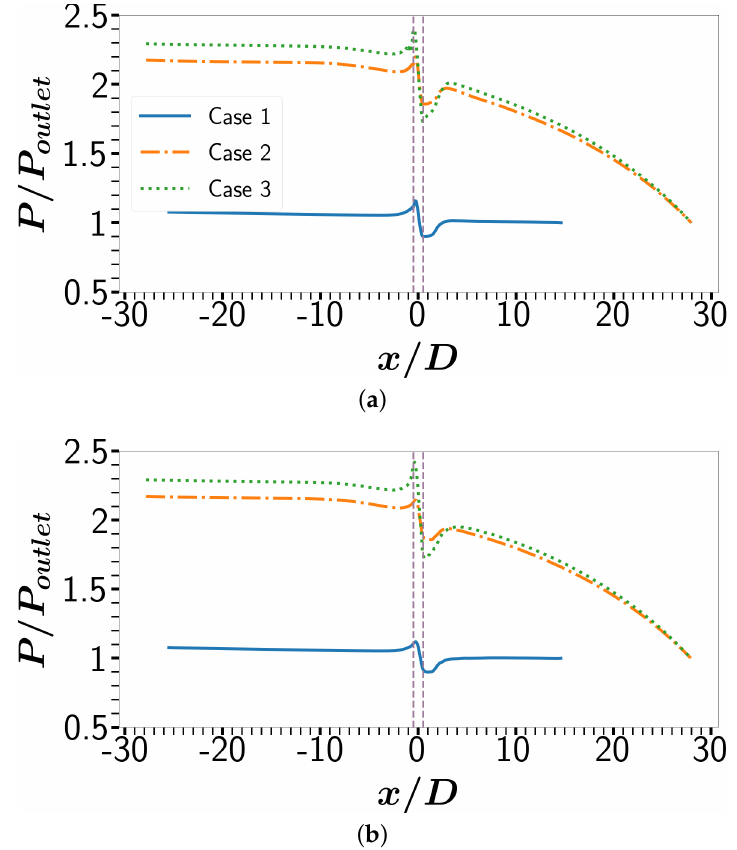
Figure 6. Mean pressure in all cases at ( a ) y + = 5 and ( b ) y + = 50.